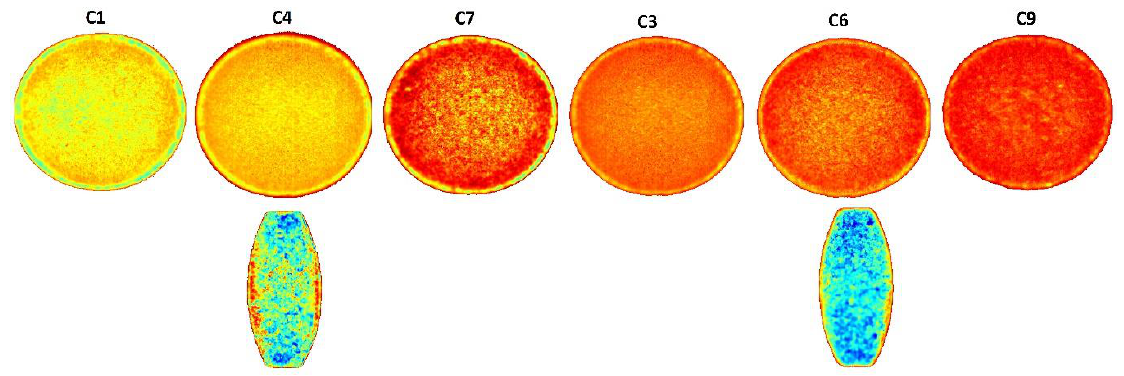
Figure 2. Principal component analysis (PCA) images of tablets coated with blends of CAB 171-15/C- A-P.